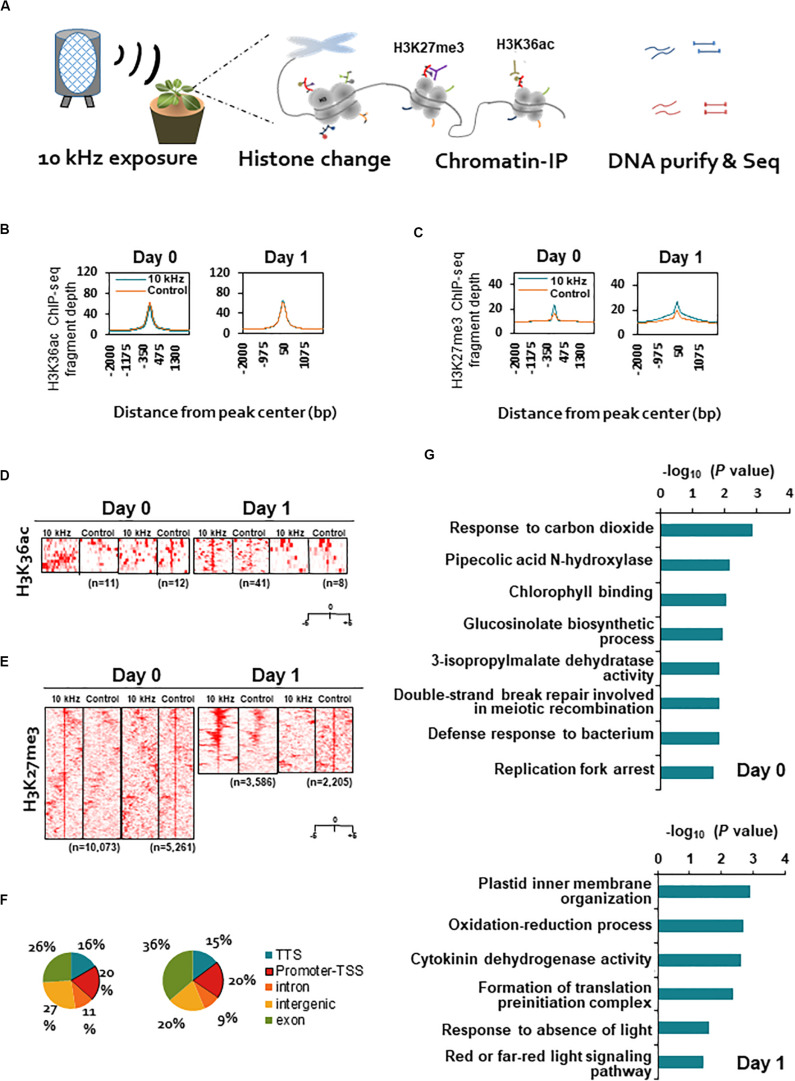
Genome-wide profiling of H3K36ac and H3K27me3 modifications in SV-treated plants during R. solanacearum infection. (A) Schematic representation of the experimental design used for chromatin immunoprecipitation (ChIP)-seq analyses of H3K36ac and H3K27me3 modifications in 10 kHz-treated and control plants at 0 and 1 dpi. (B,C) Fragment depth from peak center of H3K36ac (B) or H3K27me3 (C). (D,E) Heatmaps of ChIP-seq signals at ± 5 kb around the peak midpoints of H3K36ac (D) or H3K27me3 (E). (F) Distribution of H3K27me3 sites within genic regions. A 1 kb region upstream of the transcription start site (TSS) was defined as the promoter. (G) Gene ontology (GO) analysis of genes carrying the H3K27me3 mark in promoter regions.